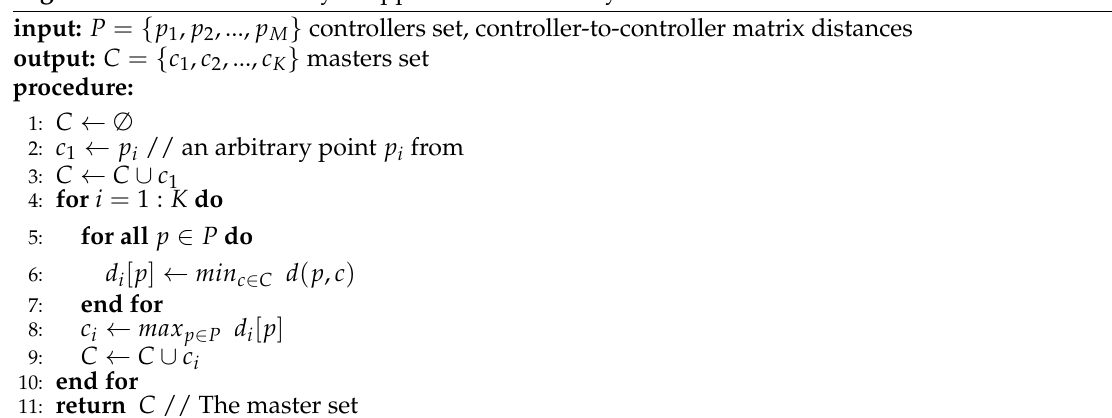
Algorithm 1 Find Masters by 2-Approximation Greedy k-Center